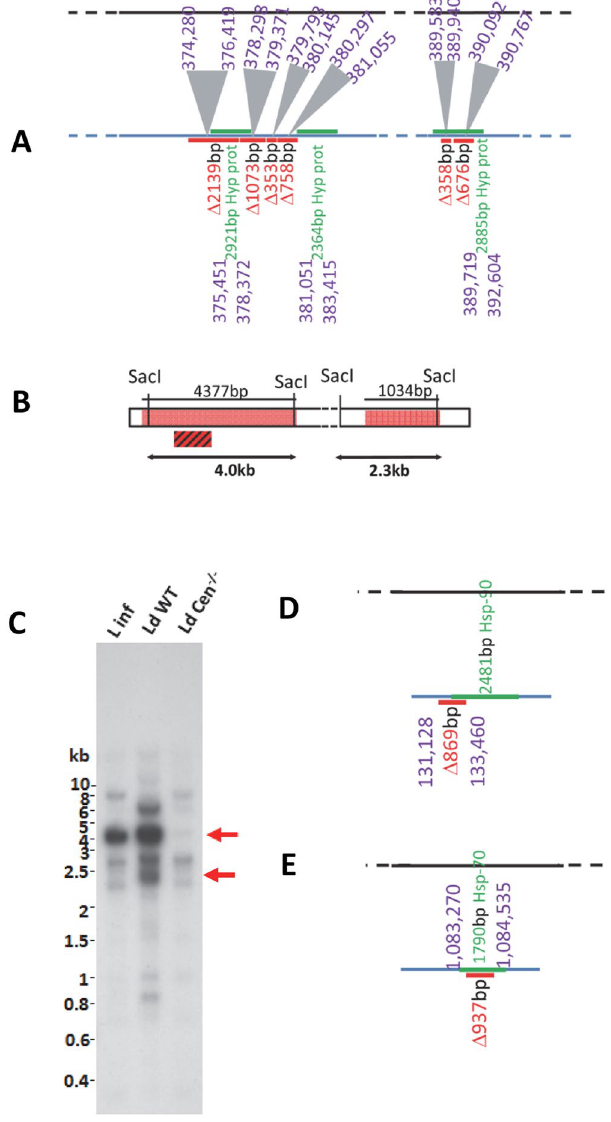
Figure 5. Additional deletions observed in LdCen − / − mutant in Chromosomes 16. ( A ) The deletions predicted by the bioinformatics analysis are shown as red bars. The gene arrangement in the reference L . donovani genome with the gene listing is shown as a black bar. The open reading frames are shown as green bars and the untranslated regions (UTR) are shown as blue bars. The size of the deletion is also indicated. The predicted hypothetical protein coding genes are indicated with the gene identifiers are shown. ( B ) The restriction map upon SacI digestion is shown. The location of the probe used in hybridization experiments is indicated with red. The predicted size of the fragment upon Southern hybridization is indicated as black arrows. ( C ) Southern hybridization of SacI digested L . infantum , LdWT and LdCen − / − gDNA is shown. Absence of the 4.0 kb and 2.3 kb bands is indicated with a red arrow. Additional deletions in LdCen − / − genome ranging from 700–900 bp found in chromosomes ( D ) 33 and ( E ) 8 and the nearest predicted protein coding ORFs are